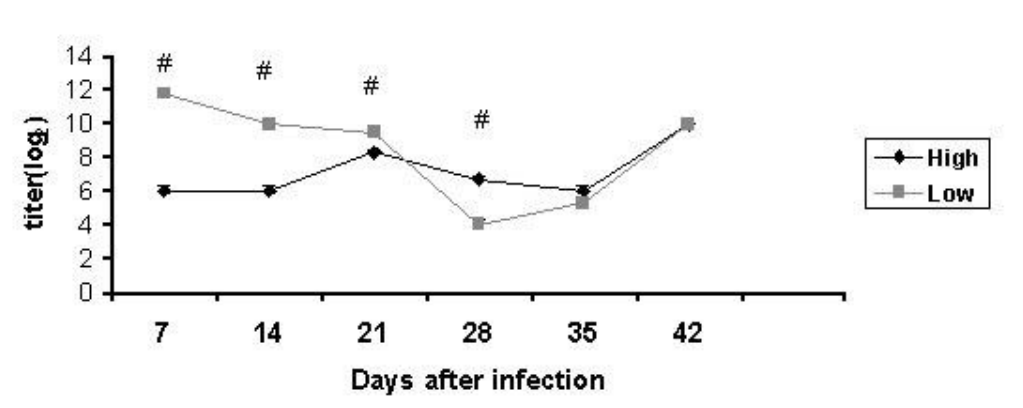
Figure 10. Total anti- Mycobacterium bovis- AN antibody titers (log ) in sera of High 5 2 and Low antibody producer (Selection IV-A) mice at different periods after experimental infection. Dosage was performed by direct microagglutination and of the mean +/- standard deviation. results were expressed as log 2